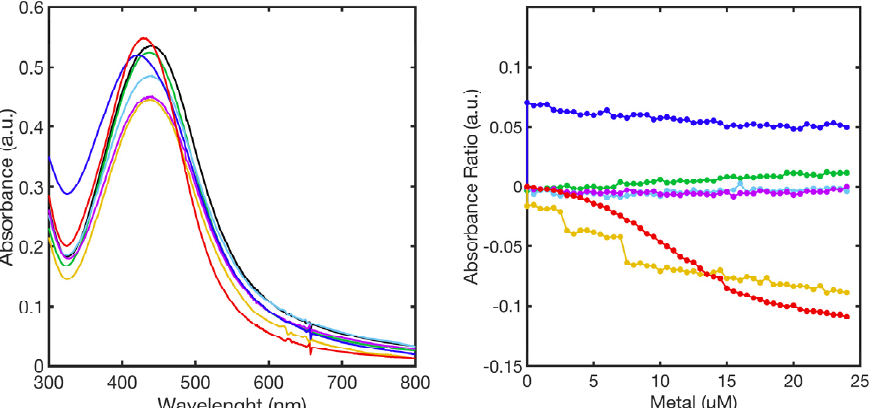
Figure 4. SPABs of ML–AgNPs@11MUA (black line) obtained at the highest concentration of metal ions ( left -panel); calibration curve showing the relationship between absorbance ratio and metal ion concentration used in the titrations ( right -panel). Ni 2+ (green line), Mn 2+ (blue line), Cu 2+ (red line), Zn 2+ (cyan line), Co 2+ (purple line), and Cd 2+ (yellow